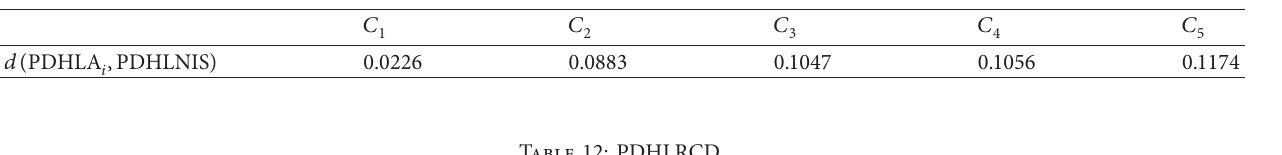
Table 11: d ( PDHLA